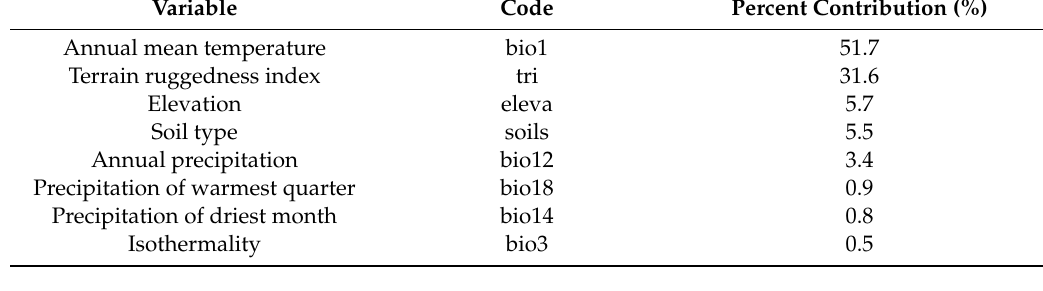
Table 3. Environmental variables used in the study and their percentage contributions, and the maps that show the spatial distribution of the important variables are presented in Figure A1.